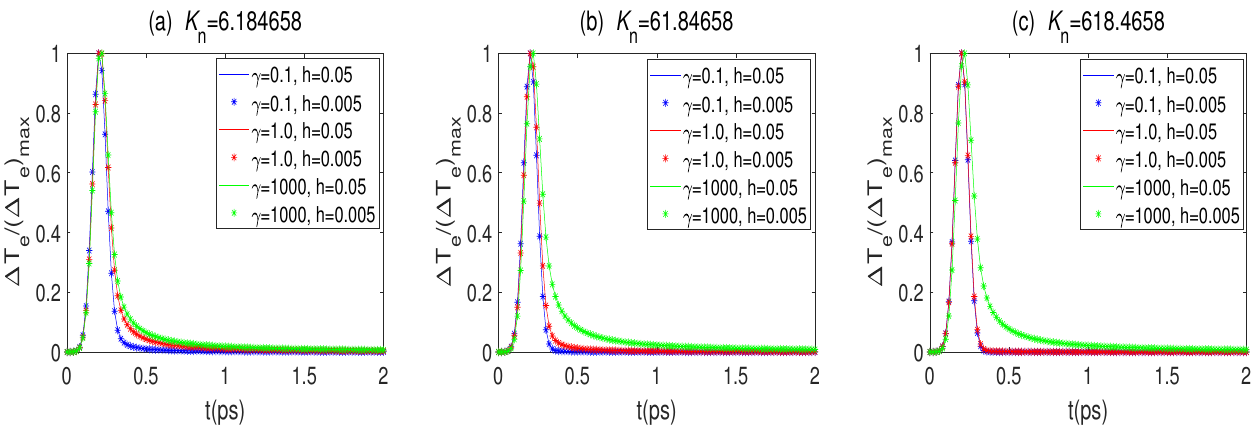
Figure 3. Changes in electron temperature ∆ T e / ( ∆ T e ) max and various K n , γ , and ( α , β ) = ( 0.5,0.5 ) .